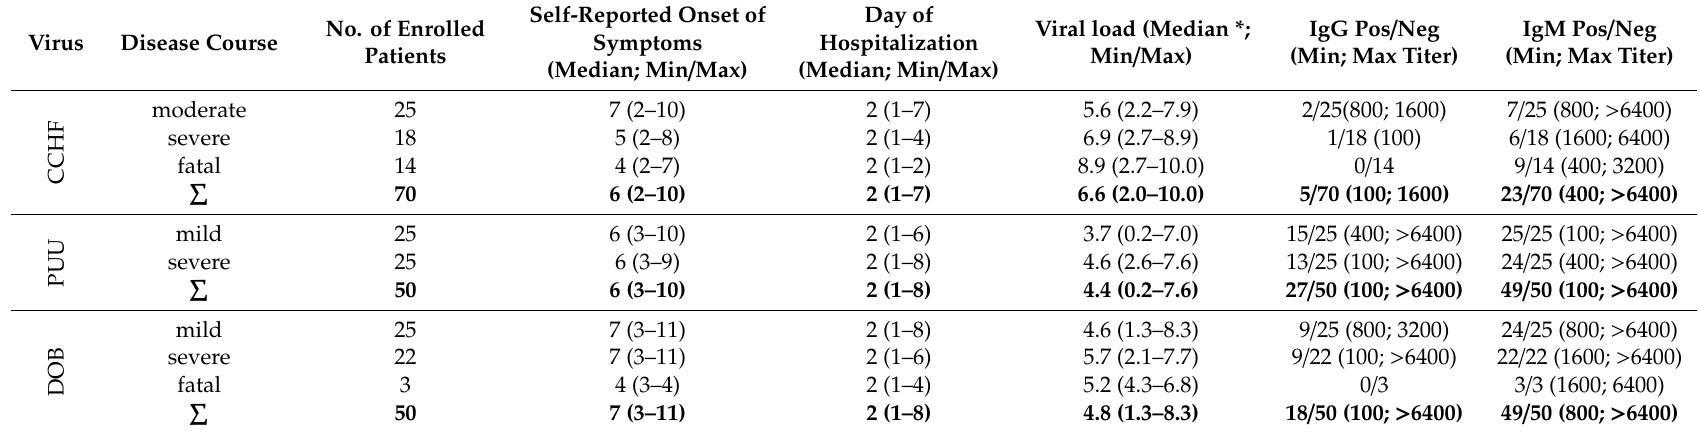
Table 1. Antibody response, viral RNA load, self-reported onset of symptoms and day of hospitalization, by disease course and causative agent. No. of Enrolled Virus Disease Course